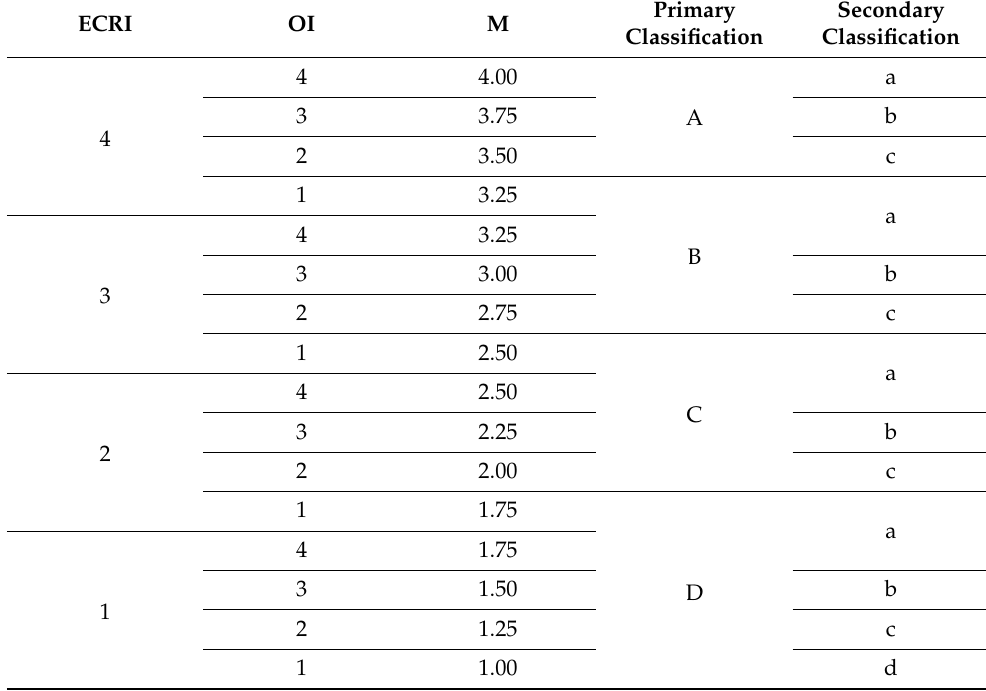
Table 1. Classification table of model calculation